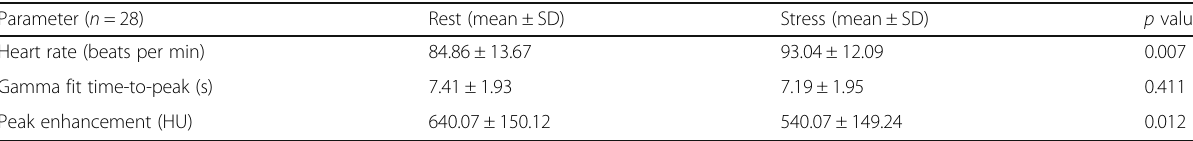
Table 1 Rest and stress comparison